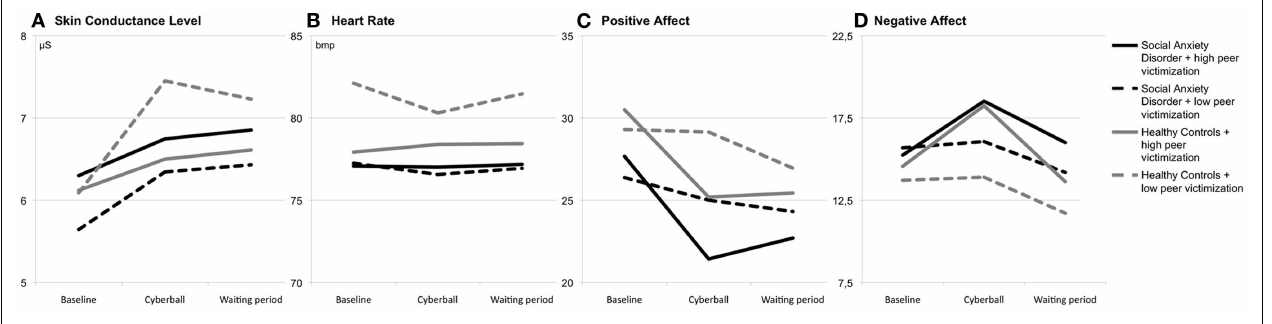
FIGURE 1 | Group means of skin conductance level (A), heart rate (B), positive affect (C), and negative affect (D) at baseline, during/after the Cyberball game and during/after the waiting period .